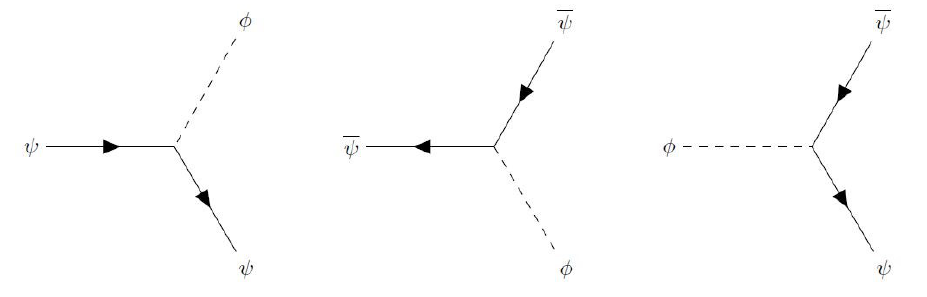
Fig. 2. The three branching processes allowed in our